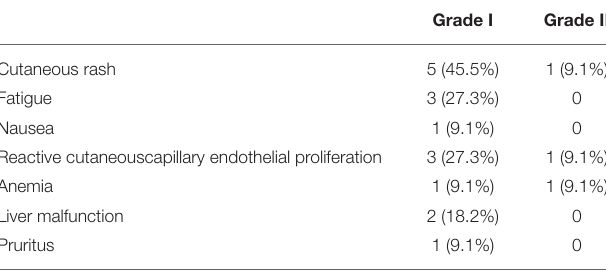
TABLE 6 | Immune related adverse